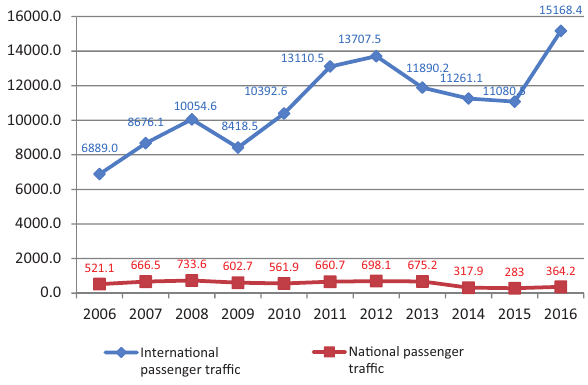
Figure 8. Air transportation efficiency in reference